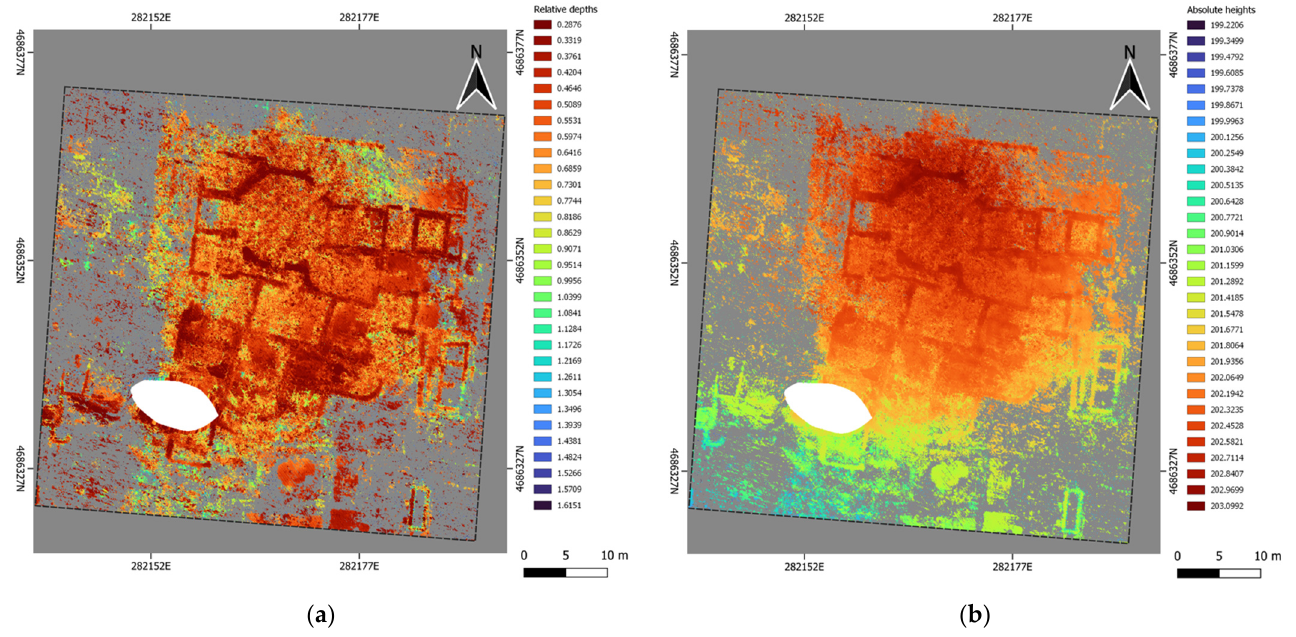
Figure 10. Results of plug-in application in the bath complex area: ( a ) “merged signal peaks map” with estimated depth value, ( b ) “buried feature elevation map”, in absolute height (image by M. Serpetti).